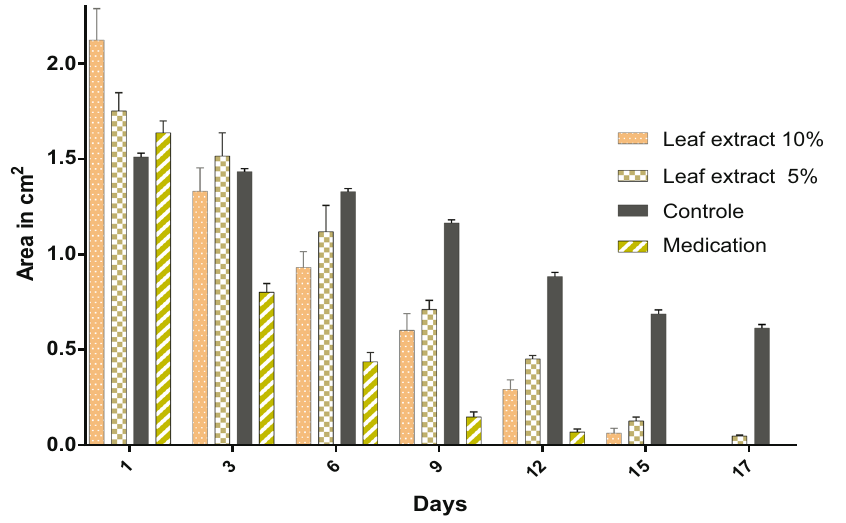
Figure 8: Healing e ff ect of ethanolic extract 5% and 10% W. frutescens applied dermally and sulfadiazine silver. Values are expressed as average ± SEM, p < 0.05 is considered to be signi fi cant.